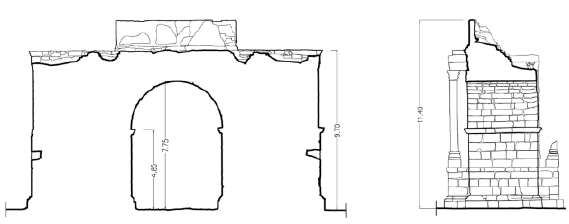
Figure 8. Longitudinal cross-section and north elevation (from the 2017 survey).